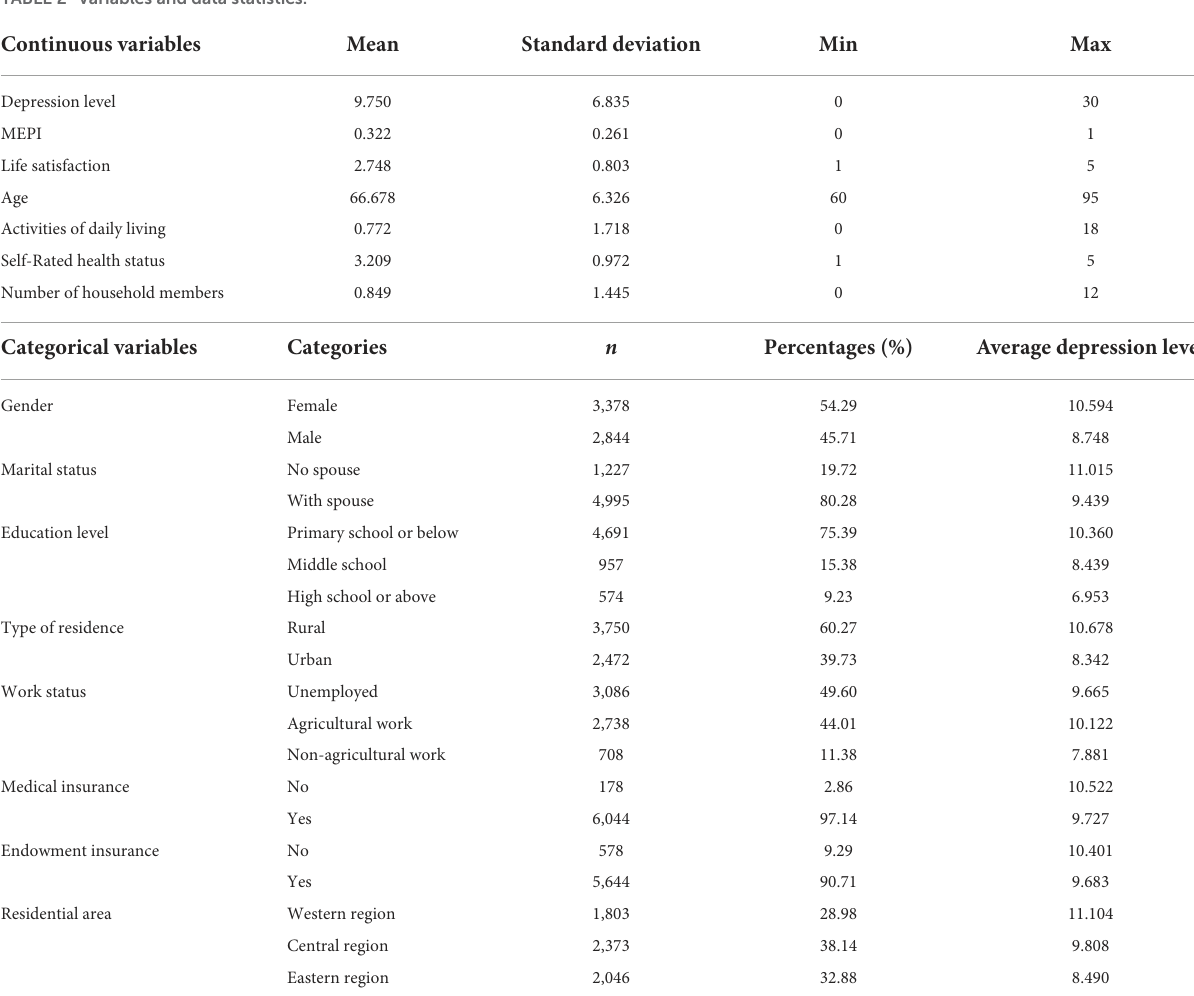
TABLE 2 Variables and data